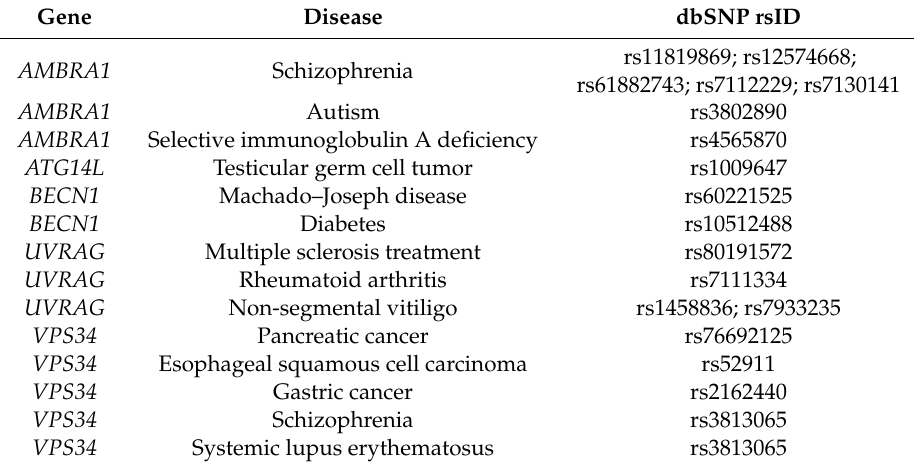
Table 2. Clinically relevant SNPs in PI3KC3